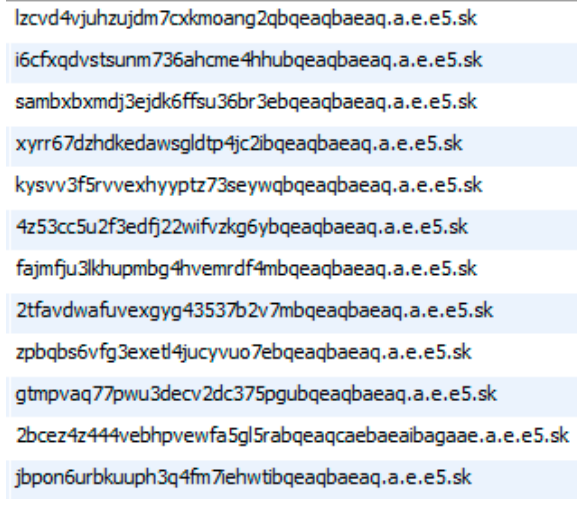
Figure 2. Suspected domain names.